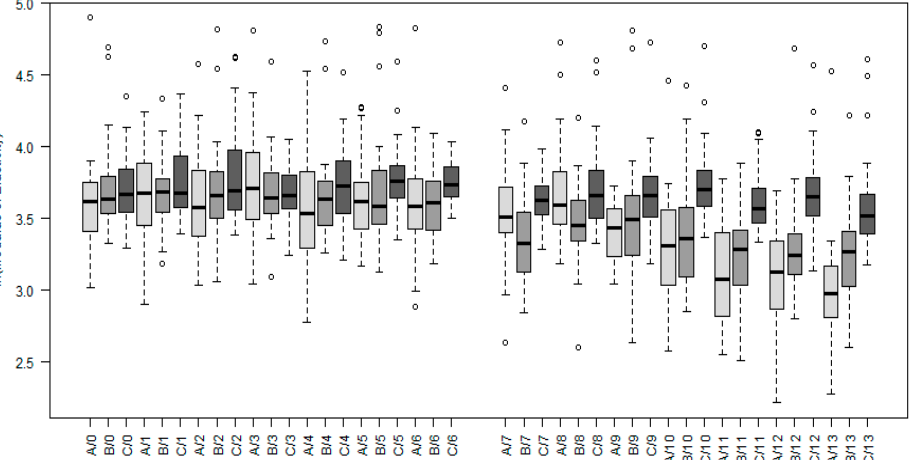
Figure 5. Boxplots of modulus of elasticity measured on three samples differing in thickness of the root canal wall (A–0.8 mm, B–1.2 mm, C–1.6 mm). The measurements were taken on different locations, where 0 denotes measurements in the center of a sample and 13 on the periphery. Indexes 0–6, therefore, represent measurements in the central matrices and 7–13 measurements in the peripheral